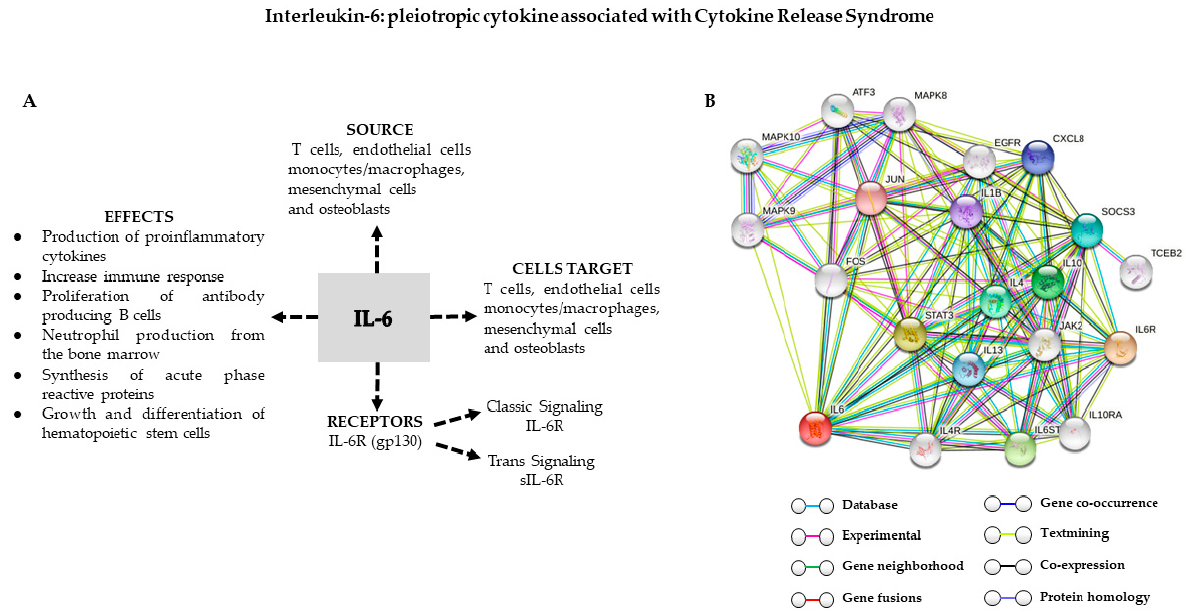
Figure 2. ( A ) Source and biological functions of IL-6. ( B ) Genetic interaction network (String: https://string-db.org) that evaluates pathways and visualizes the connection among target genes according to the literature search. IL6R: interleukin-6 receptor subunit alpha; STAT3: signal transducer and activator of transcription 3; IL6ST: interleukin-6 receptor subunit beta; IL10: interleukin-10; IL4: interleukin-4; SOCS3: suppressor of cytokine signaling 3; IL13: interleukin-13; CXCL8: interleukin-8; IL1B: interleukin-1 beta; JUN: transcription factor AP-1.